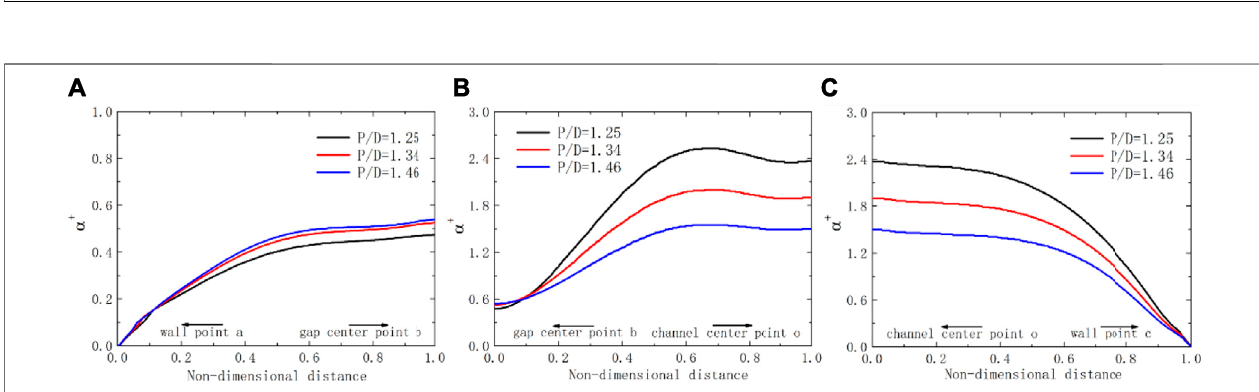
FIGURE12| Schematicdiagramofdimensionlessthermaldiffusivityoverlinesforthesquarelatticeat Pe =2000withdifferent P/D ratios. (A) lineab; (B) linebo; (C) line oc.